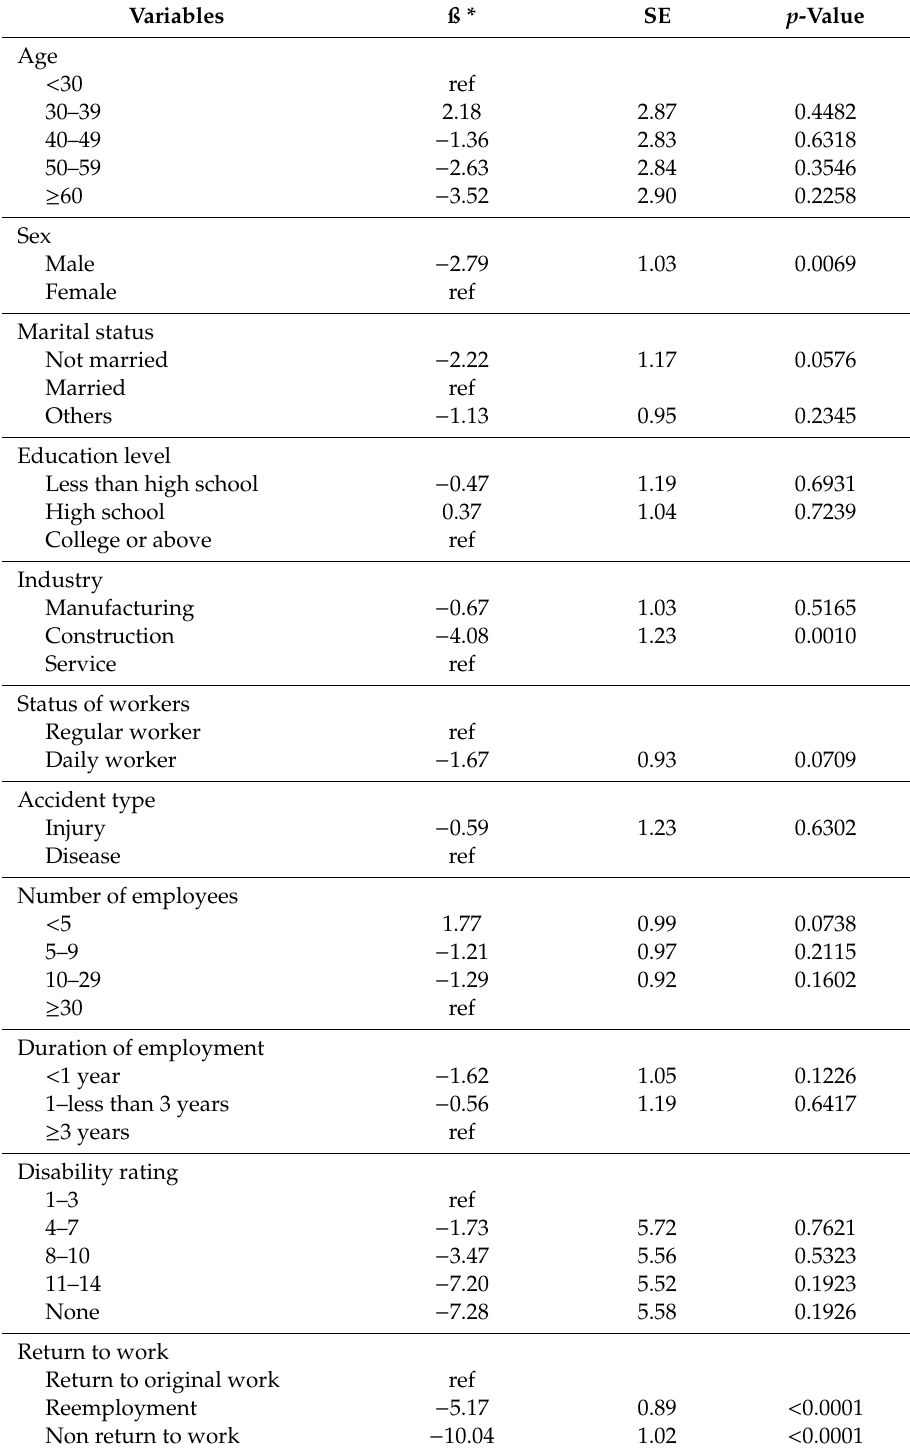
Table 5. Relationship between the general characteristics and five-year average of post-accident income minus the income before the industrial accident (unit: million